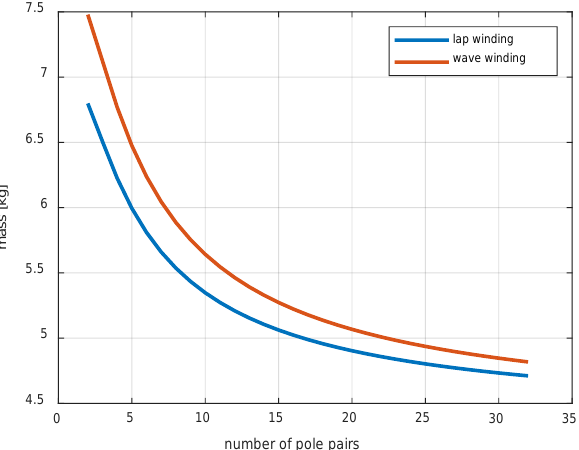
Figure 12. Mass of one CM segment as a function of the number of pole pairs for lap and wave windings.